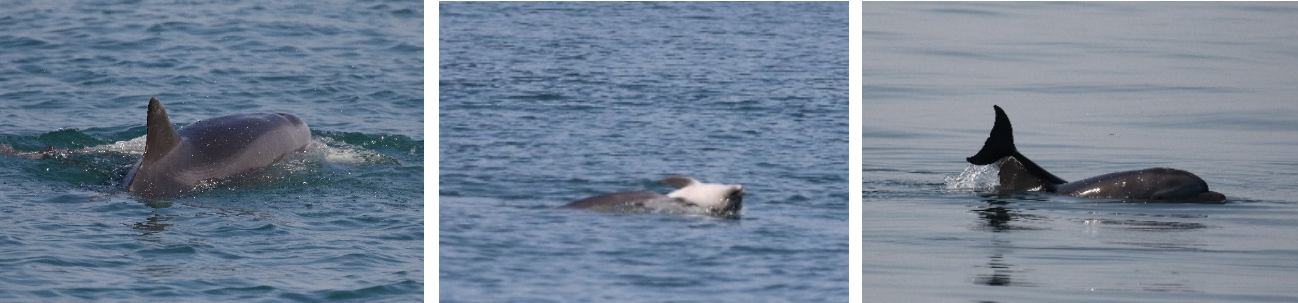
Figure 8. UNIRM_142 passing over the carcass ( left picture), pushing it up with the rostrum ( middle picture) and carrying it on the dorsal fin ( right picture).